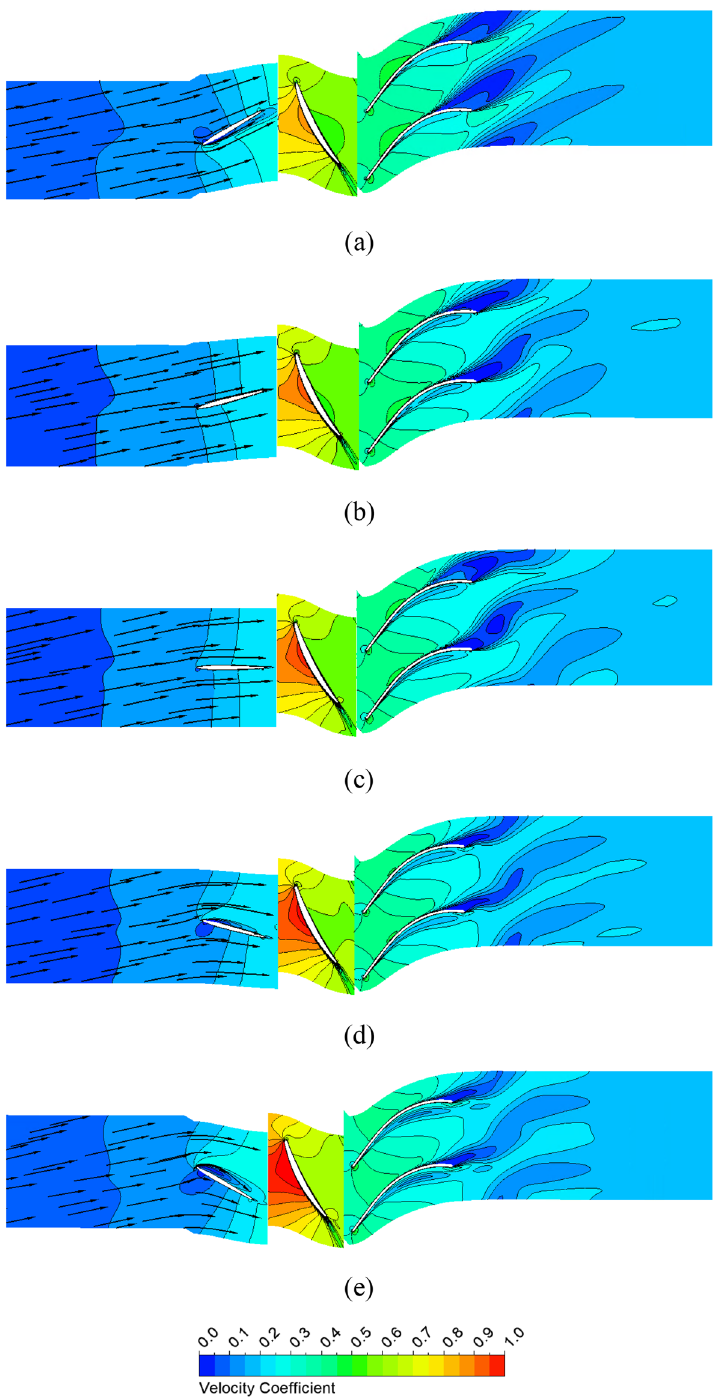
Figure 20. Velocity distribution at 50% span for various IGV’s setting angles. ( a ) − 30°, ( b ) − 15°, ( c ) reference case (0°), ( d ) 15°, and ( e )